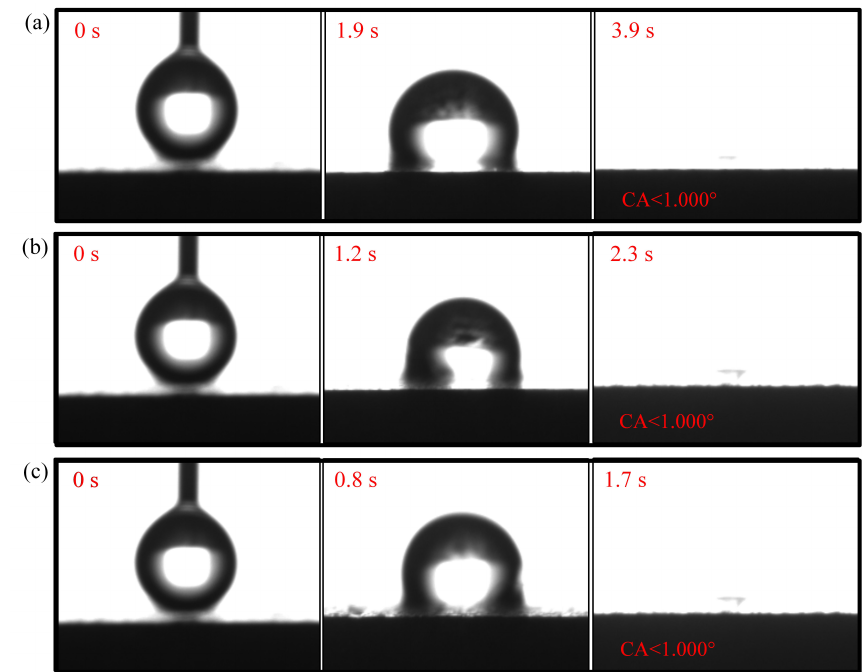
Figure 9. Wettability test of 9-CCC: ( a ) α region; ( b ) β region; ( c ) γ